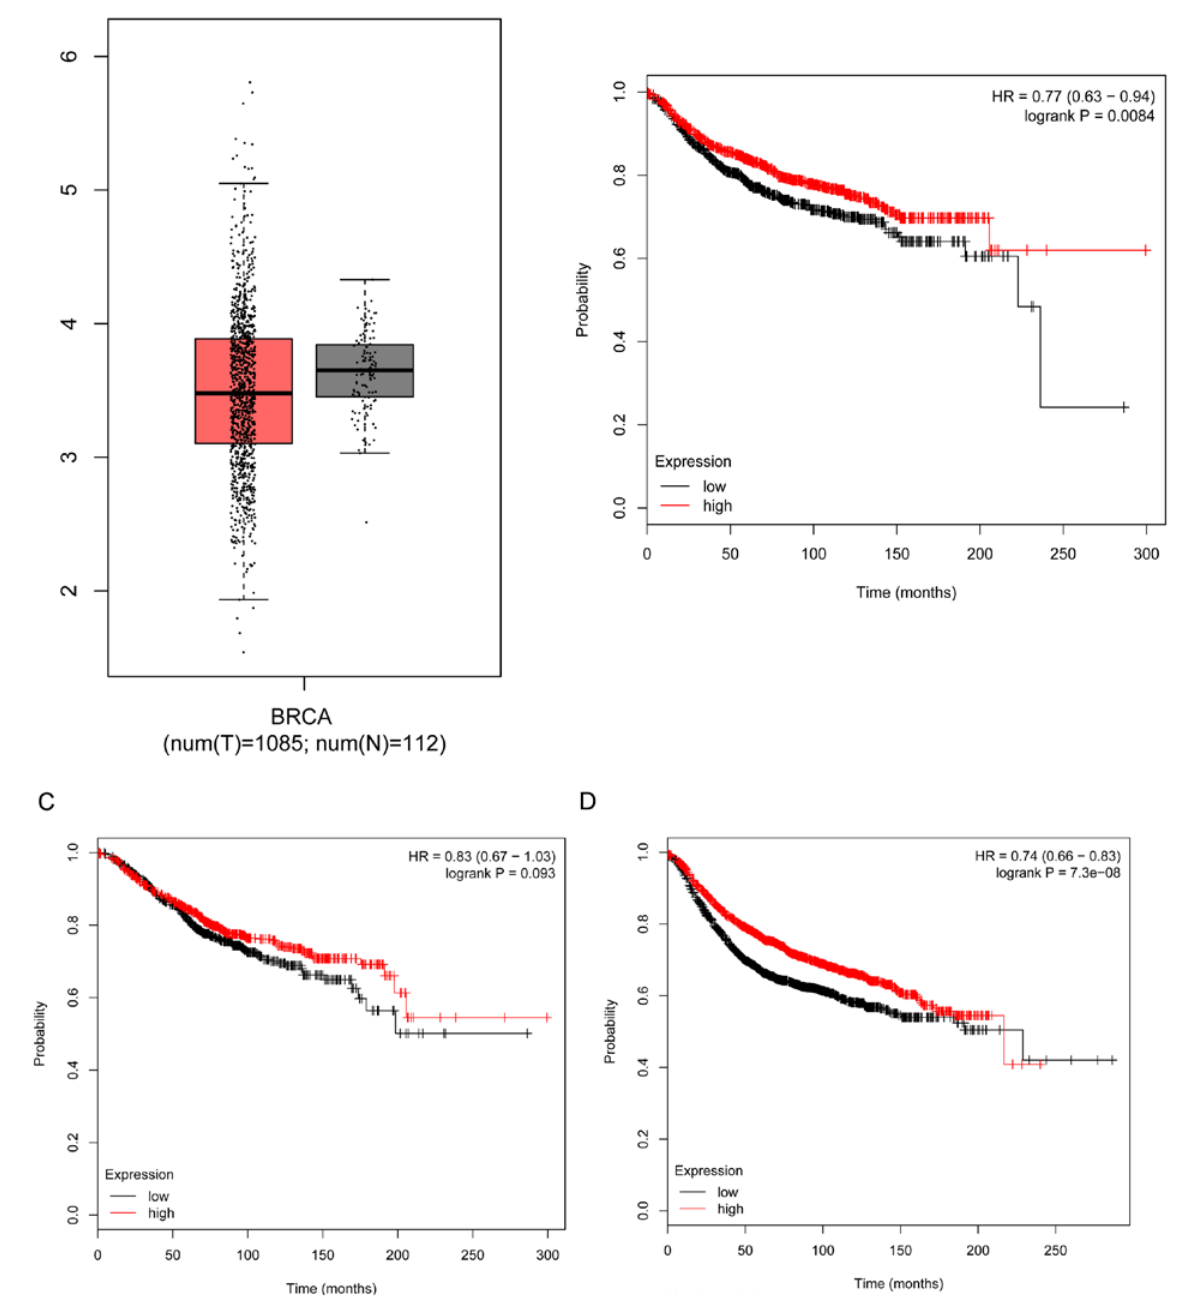
Figure 2: A NF2 mRNA is down-regulated in breast cancer tissues compared to normal tissues in TCGA cohort, analyzed with the Gene Expres- sion Profiling Interactive Analysis (GEPIA). B Relationship between NF2 expression level and distance metastasis free survival of patients with breast cancer. C Relationship between NF2 expression level and overall survival of patients with breast cancer. D Relationship between NF2 expression level and relapse free survival of patients with breast